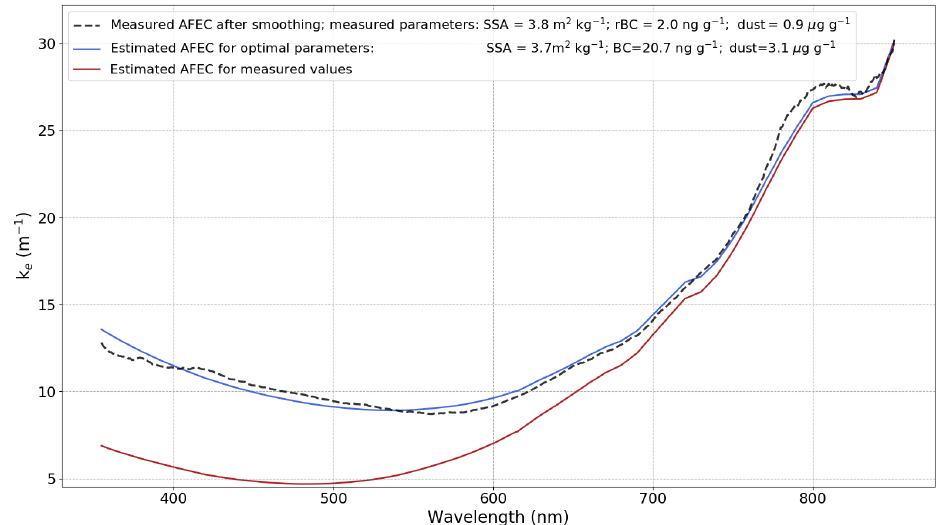
Figure 14. AFEC computation on a ZOI containing liquid water (between 15 and 18cm on the SOLEXS profile 002 measured on 28 March 2017). The measured AFEC after filtering (black dotted line) is compared to the AFEC modelled using optimal parameters (blue curve) and to the AFEC modelled with measured values (red